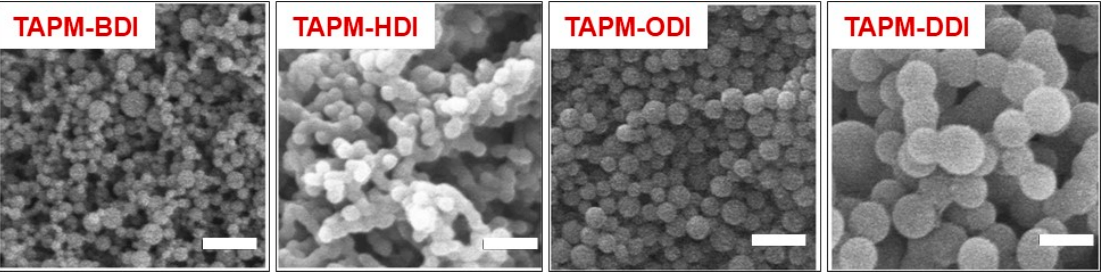
Figure 1 . SEM images of PUA powders precipitated into acetone from the sols of the monomer pairs, as indicated, at 50% reaction conversion. Initial solution concentration: 0.04 g mL –1 . Scale bar: 400 nm. Adapted from Ref. [89] with permission from The Royal Society of Chemistry.